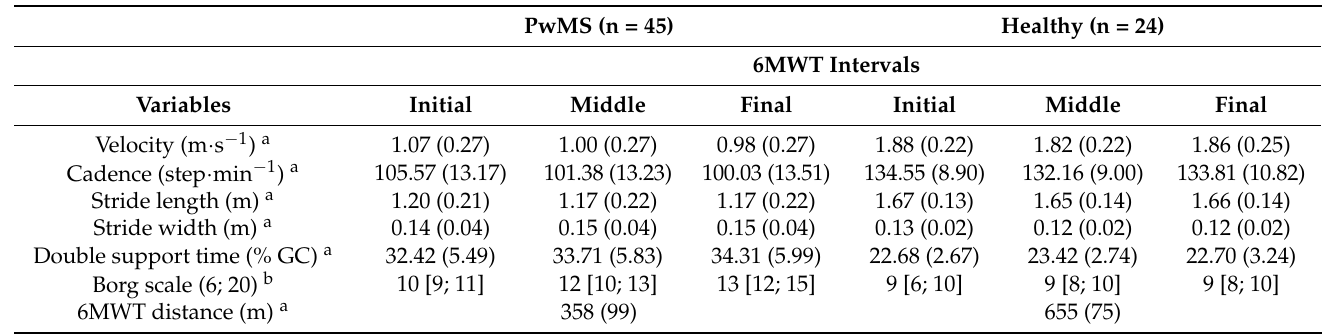
Table 2. Spatio-temporal walking parameters and perceived exertion during the three pre-defined one-minute intervals of the 6MWT for PwMS and healthy people.